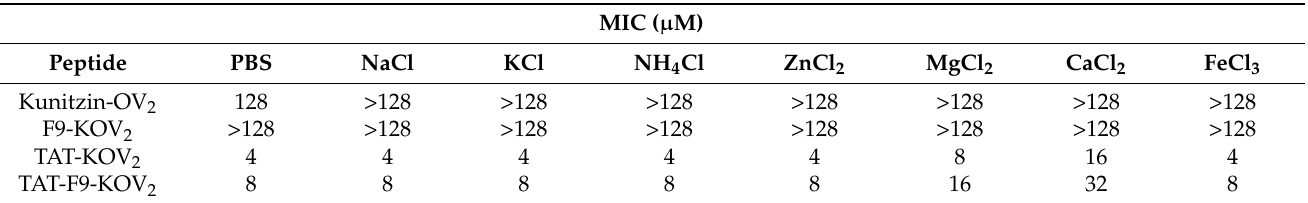
Table 4. The MICs ( µ M) of kunitzin-OV 2 , F9-KOV 2 , TAT-KOV 2 , and TAT-F9-KOV 2 against E. coli in the presence of different salts. MIC ( µ